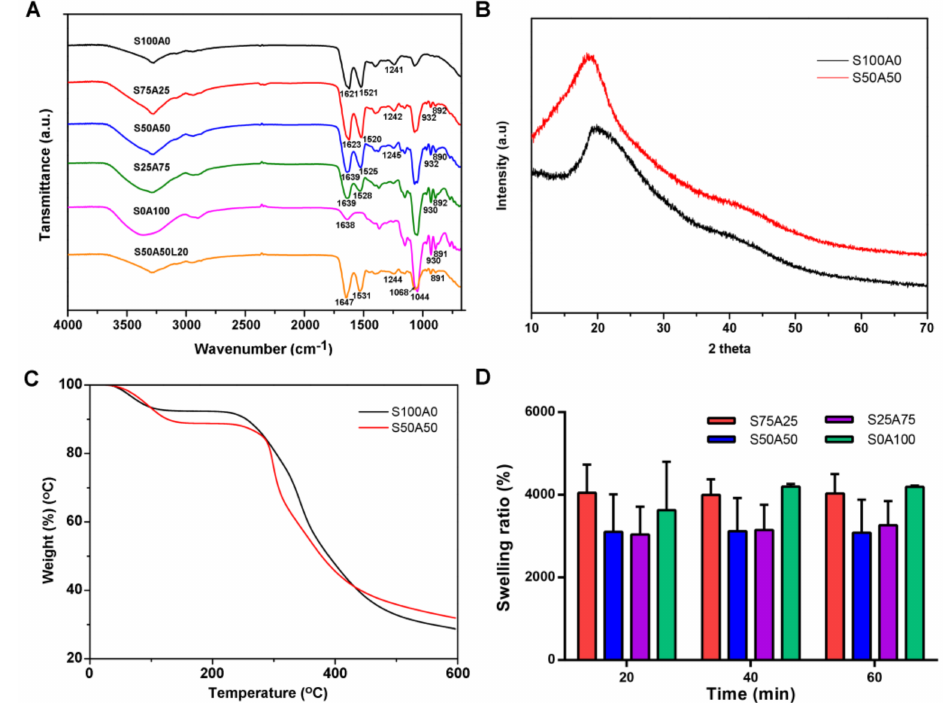
Figure 3. Characterizations of SS/AR gels. ( A ) Attenuated Total Reflection Fourier Transform Infrared Spectroscopy (ATR-FTIR); ( B ) X-Ray Diffraction (XRD); ( C ) Thermogravimetric Analysis (TGA); and ( D ) swelling